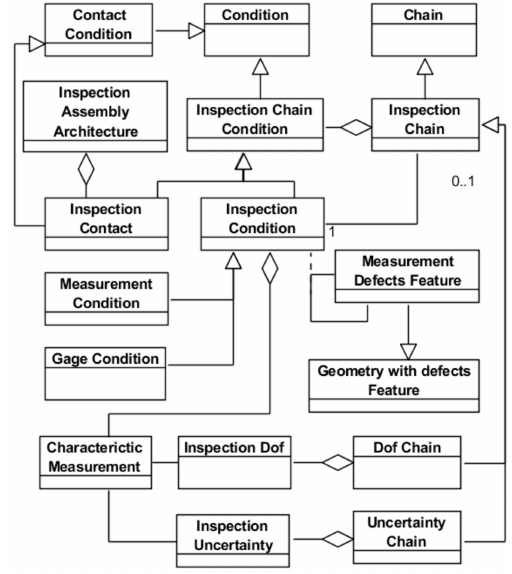
Figure 9. Inspection Assembly Chain